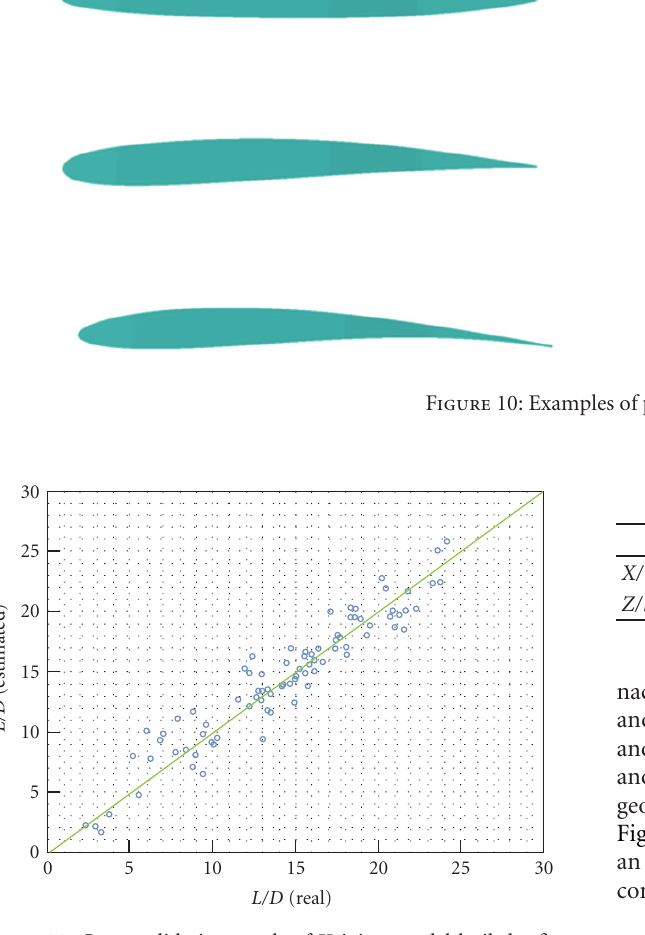
Figure 11: Cross-validation result of Kriging model built by first sampling points.